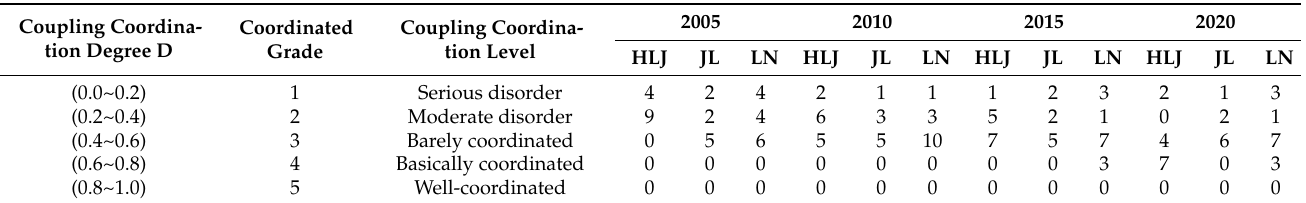
Table 4. Grading and level of multifunctional coupling coordination degree of cultivated land and related quantitative distribution by year, province, and city